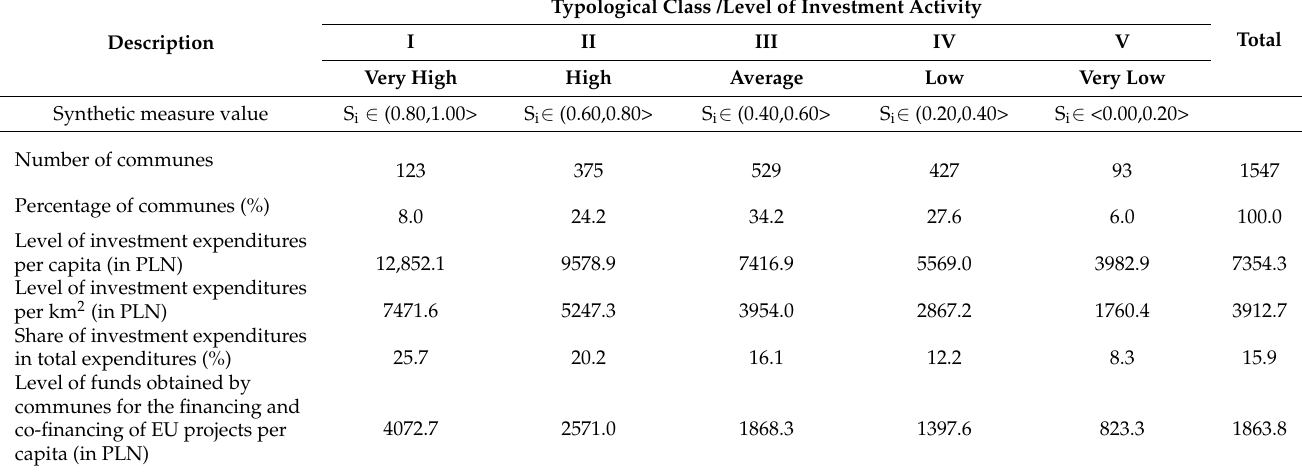
Table 5. Rural communes by macroregion arranged in terms of typological classes of investment